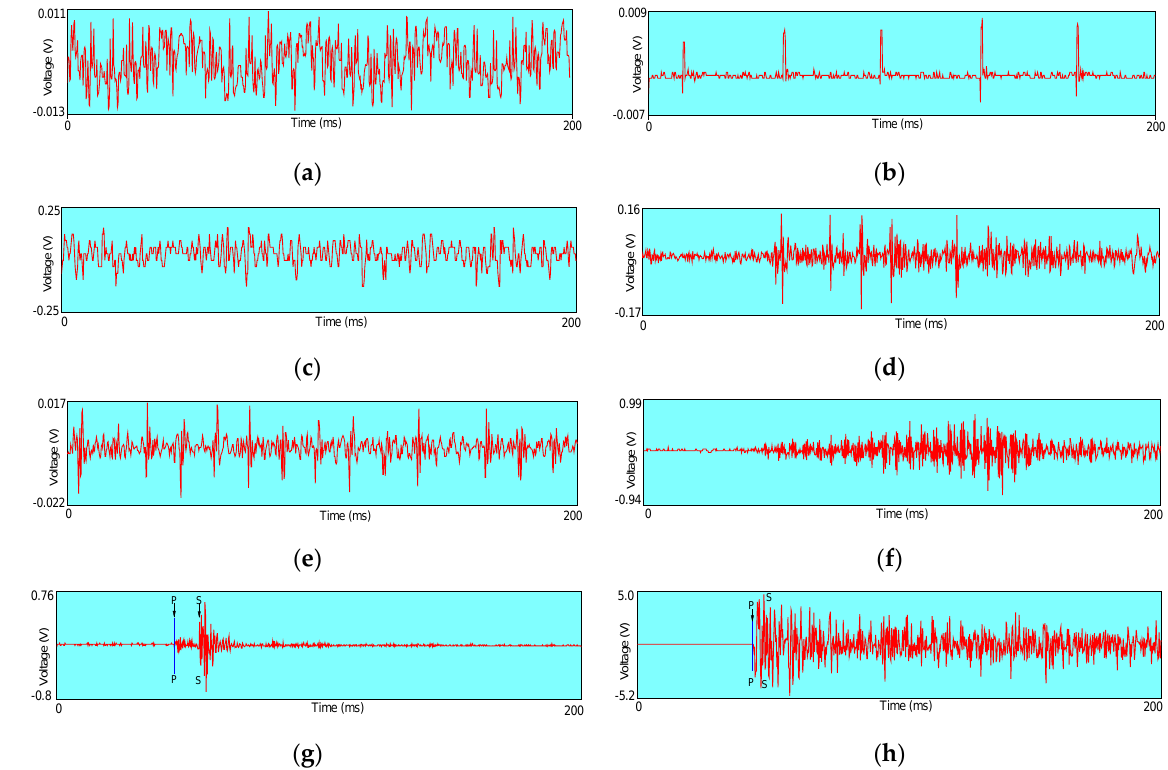
Figure 6. Waveforms of typical MS sources: ( a ) Electric current; ( b ) Knocking; ( c ) Rock drill; ( d ) Tunneling boring machine (TBM) construction; ( e ) Fan; ( f ) Locomotive whistle; ( g ) Microseisms; ( h ) Rockburst.